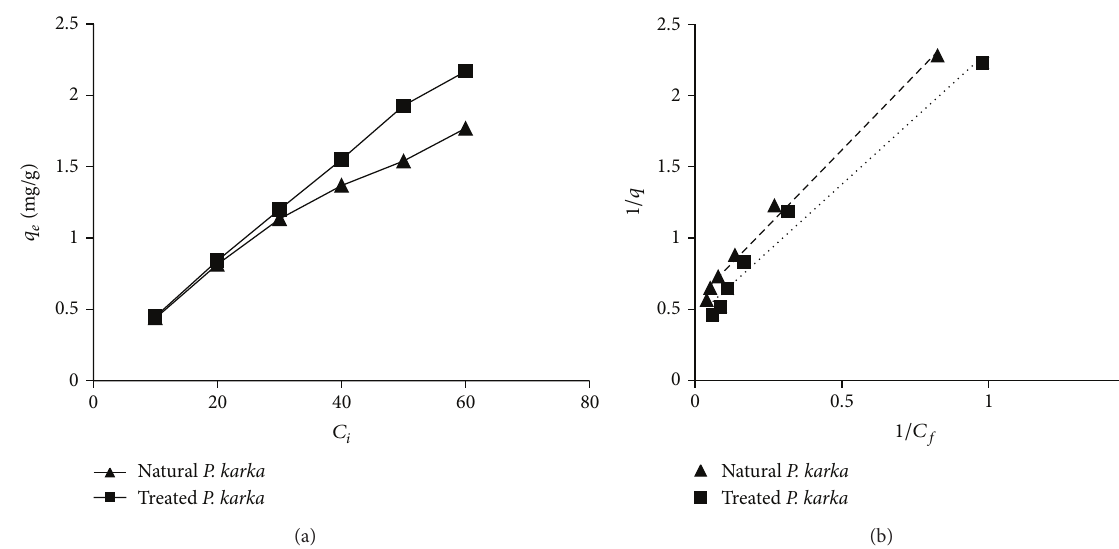
Figure 8: (a) Effect of initial metal ion concentration on adsorption capacity of natural P. karka and treated P. karka . (b) Langmuir adsorption isotherm for natural P. karka and treated P. karka (concentration = 10–60 mg/L, time = 50 and 40 minutes for natural P. karka and treated p. karka resp., 𝑇 = 298 K, agitation speed = 150 and 100rpm natural P. karka and treated p. karka , resp., dose of biosorbent = 1g/100 mL, and pH = 6 and 7 for natural P. karka and treated p. karka ,